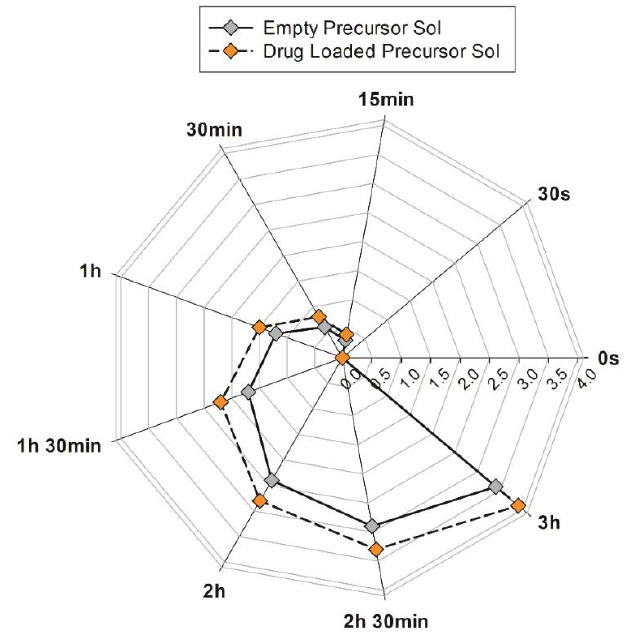
Figure 5. TSI values recorded by Turbiscan ® Lab Expert during long-term stability study of precursor solutions with (orange symbols) or without (grey symbols) drug addition. The results are representative of five independent experiments. The mean values ± standard deviation are available in Table S1 of Supplementary Materials.